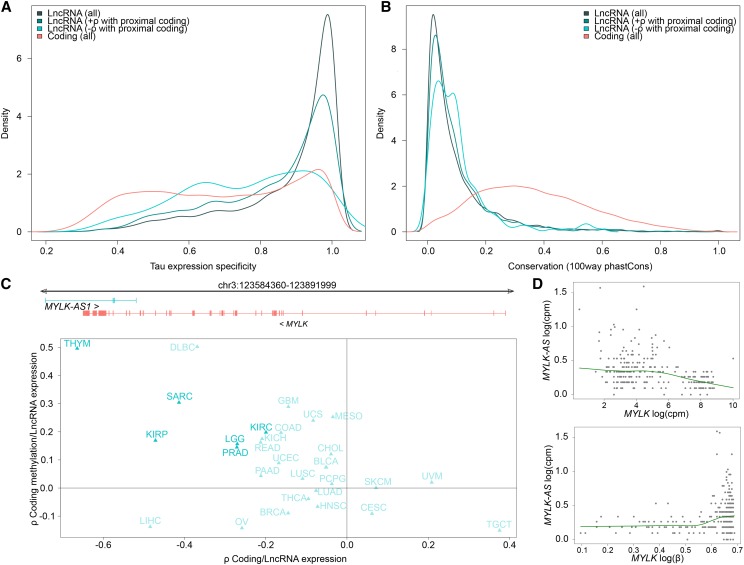
Expression specificity, sequence conservation and association of lncRNA expression and coding TSS methylation. A) Cancer type expression specificity distribution is able to demarcate lncRNAs negatively correlated with their proximal coding genes. B) A small subset of lncRNAs that shows negative correlation with their proximal coding genes show elevated levels of sequence conservation, indicative of a potential functional importance. C) Comparison of MYLK-AS1 expression against MYLK gene expression and MYLK TSS methylation across multiple cancer types. Cancer types where the expression correlation and expression/methylation correlation are both significant are marked in bold. D) The relationship between MYLK expression, MYLK-AS expression and MYLK promoter methylation across 259 sarcoma samples. Log(cpm) represents gene expression while log(β) is for coding TSS methylation beta values. LncRNA (+ρ with proximal coding) is the LCP dataset and LncRNA (-ρ with proximal coding) is the LCN dataset.